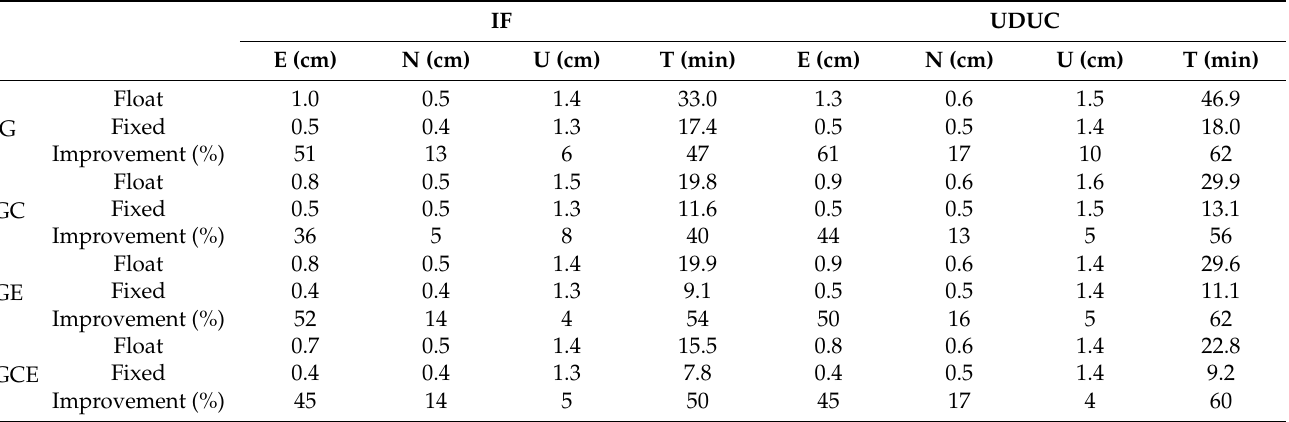
Table 5. The RMS results of position differences and convergence time of the IF model (left) and